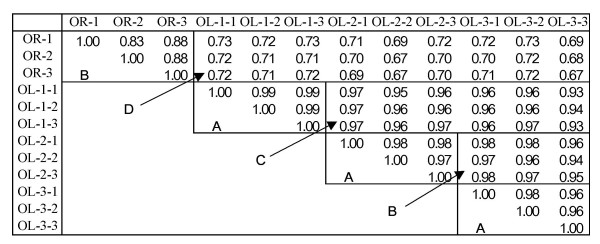
Correlation factors among the different experiments (same conditions but different treatments). A, Different sheets of microarray. B, Different citrinin treatment. C. Different labeling (dye swap), D, Different types of microarray. Dye swap was carried out with the OL-1-1, OL-1-2 and OL-1-3 sheets.